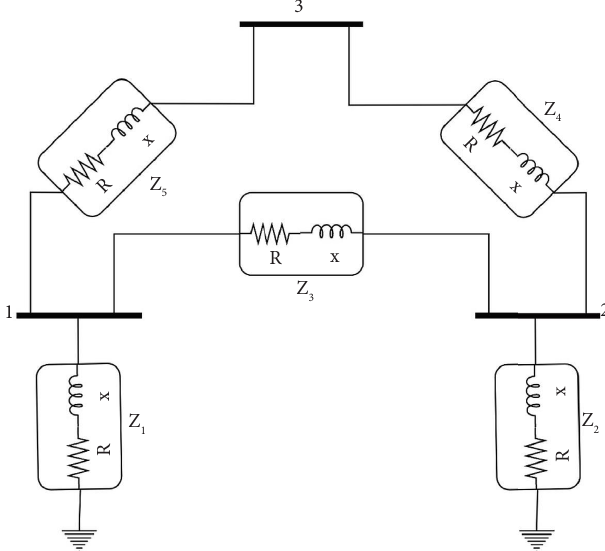
Figure 3: Representation of 3 bus network with 5